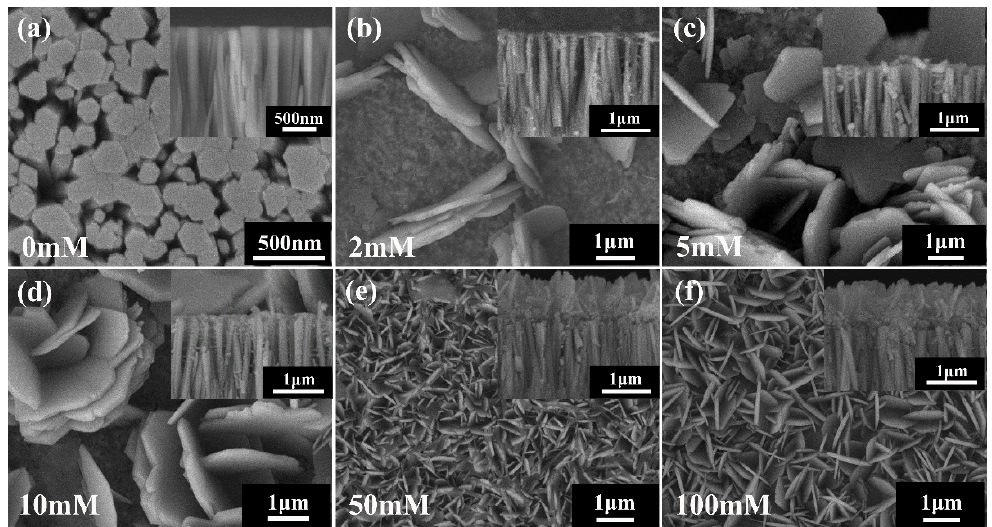
Figure 1. Surface and cross section morphologies of the ZnO nanorod arrays (NRs) and the Cu 2 (NO 3 )(OH) 3 /ZnO NR precursor. 365 nm UV illumination time was fixed at 20 min and the light intensity is 2 mW/cm 2 . ( a ) pure ZnO NRs. ( b – f ) Cu 2 (NO 3 )(OH) 3 /ZnO NR precursors deposited by the photochemical method in solutions with Cu 2+ ion concentration of 2 mM, 5 mM, 10 mM, 50 mM, and 100 mM, respectively.